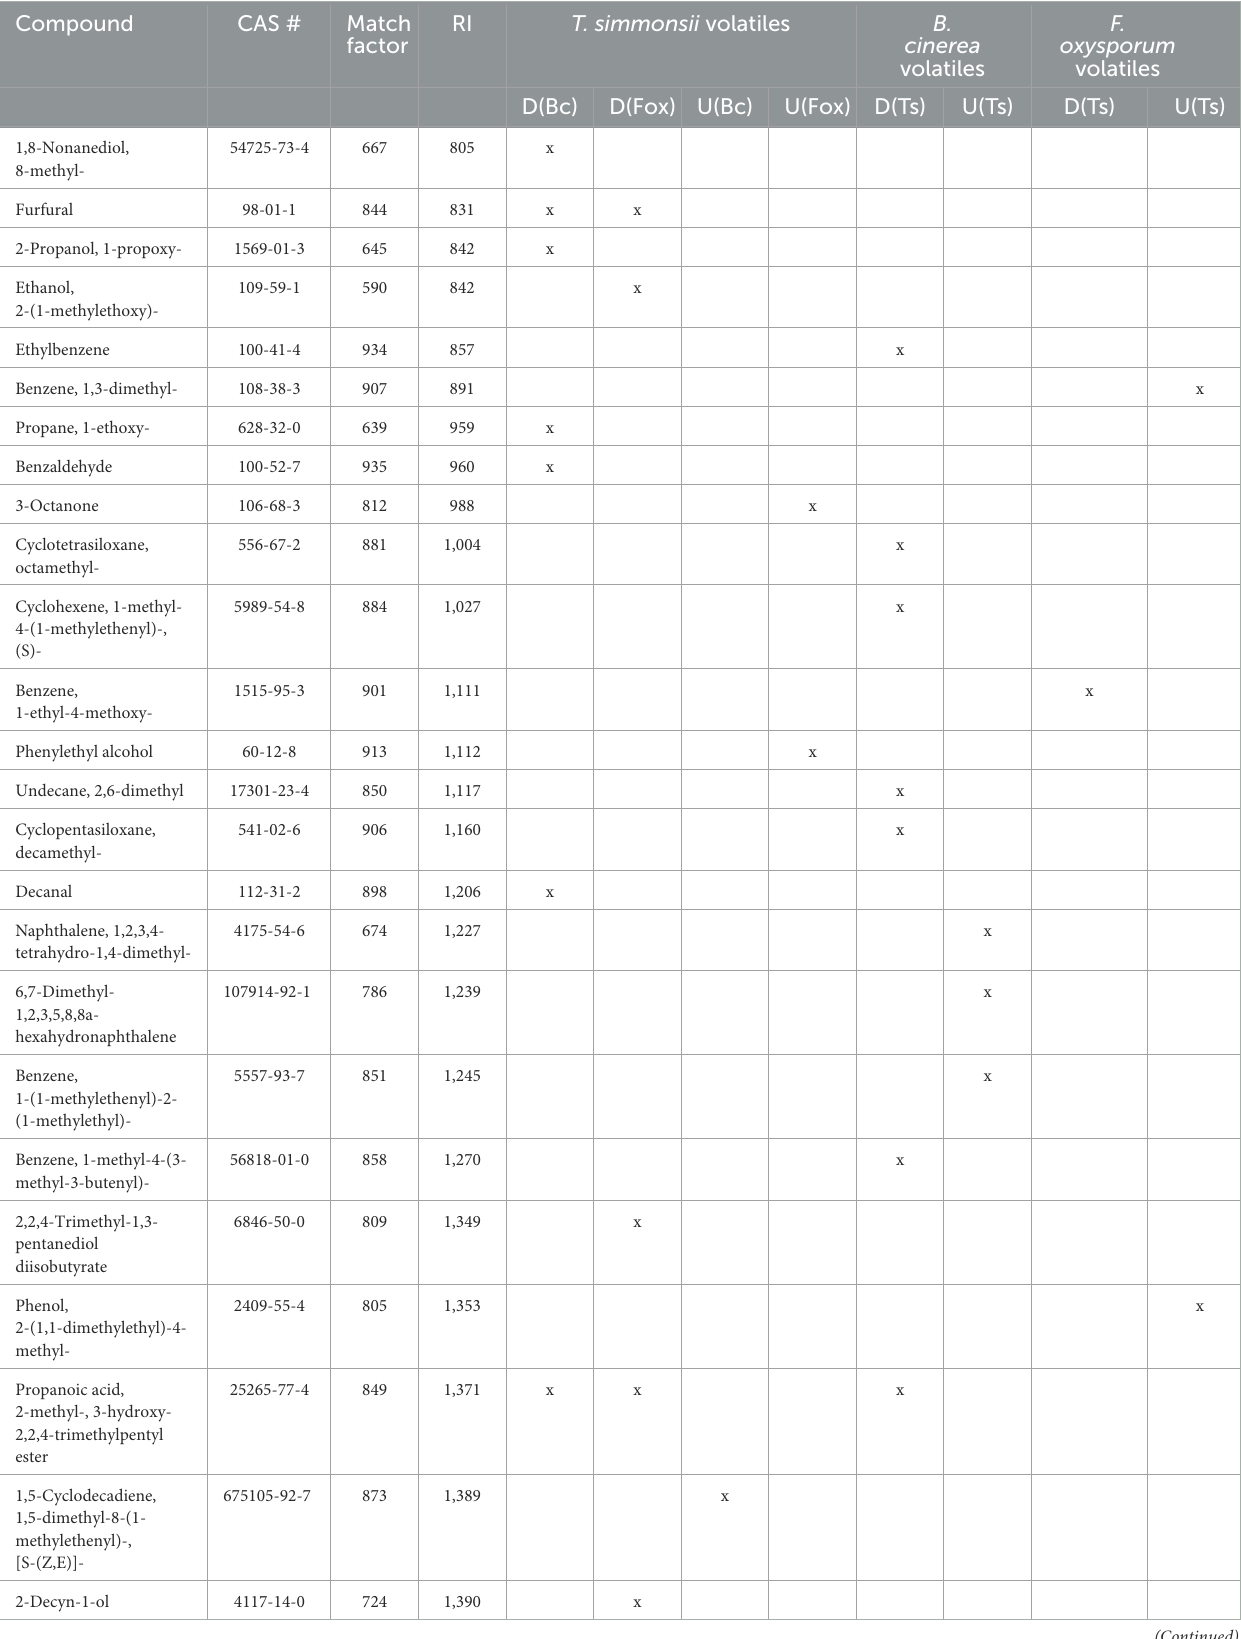
TABLE 1 List of volatiles emitted by Trichoderma, Botrytis, and Fusarium with significantly modified abundance after exposure to fungal volatiles.